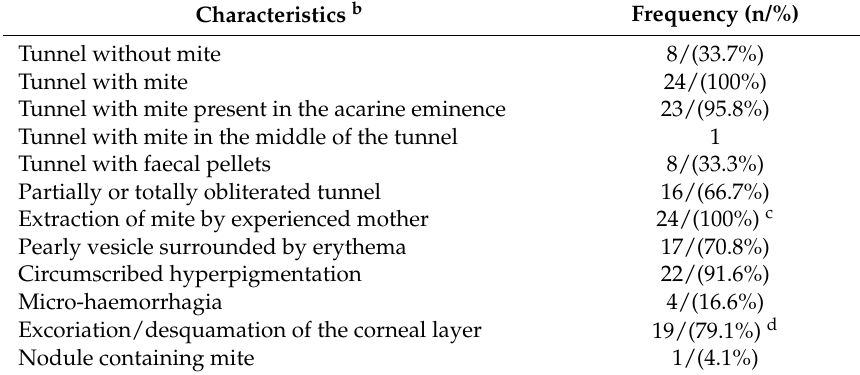
Table 3. Findings by digital microscopy in 24 scabies patients a